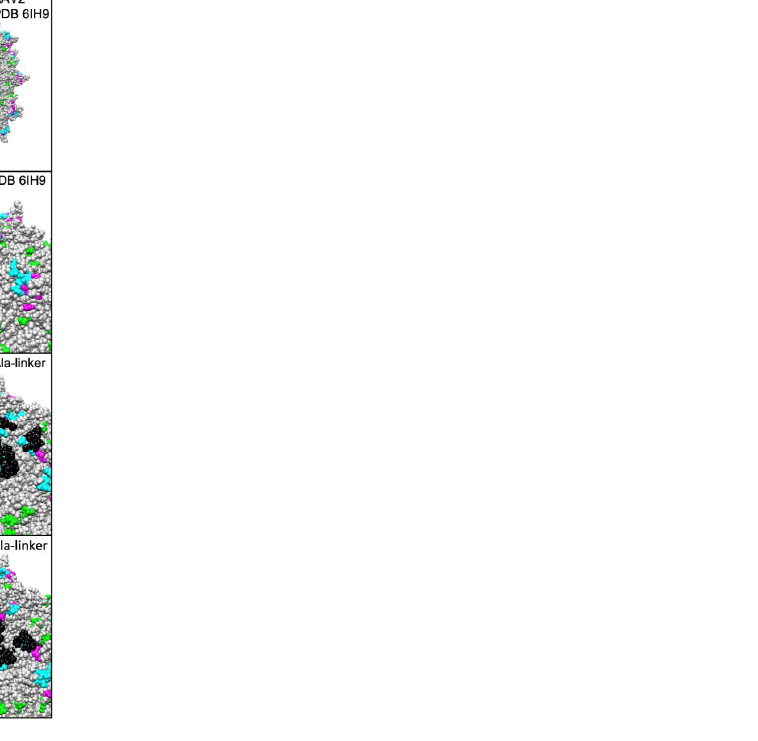
Figure 5. Modeling of the capsid epitopes of AAV2 WT and the variants AAV2.GL and AAV2.NN. Epitopes of known neutralizing monoclonal antibodies or serum (human and rabbit) of AAV2 are highlighted in different colors on the modeled structure of AAV2 WT ( A , B ) and the engineered capsids AAV2.GL ( C ) and AAV2-NN ( D ) . Residues known to participate in the binding of the mon- oclonal antibodies A20 [28,29] and C37-B [28,30] are highlighted in green and cyan, respectively. Residues highlighted in magenta represent known epitopes for human and rabbit neutralizing an- tibodies [31,32,35]. Peptide insertions in AAV2.GL and AAV2.NN are highlighted in black. As is evident from the respective models, some of the epitopes are covered and occluded by the peptide insertions in AAV2.GL and AAV2.NN. Models were generated using the RoseTTAfold deep learn- ing algorithm [36] available at https://robetta.bakerlab.org/ (accessed on 7 December 2021. The gen- erated 3D models were visualized using the UCSF Chimera software (https://www.cgl.ucsf.edu/chi- mera/ (accessed on 7 December 2021). Of note, not all tested sera contained neutralizing antibodies, and there was also no correlation between the total antibody responses and neutralizing antibodies, as previ- ously shown [34]. Endemic infection with AAV affects between 50 and 96% of the popu- lation based on antibody positivity [37], which is also reflected by our cohort. Humoral immune responses to naturally occurring AAVs develop primarily in early life [38], which is line with the lack of any correlation between antibody titers, neutralizing antibodies,